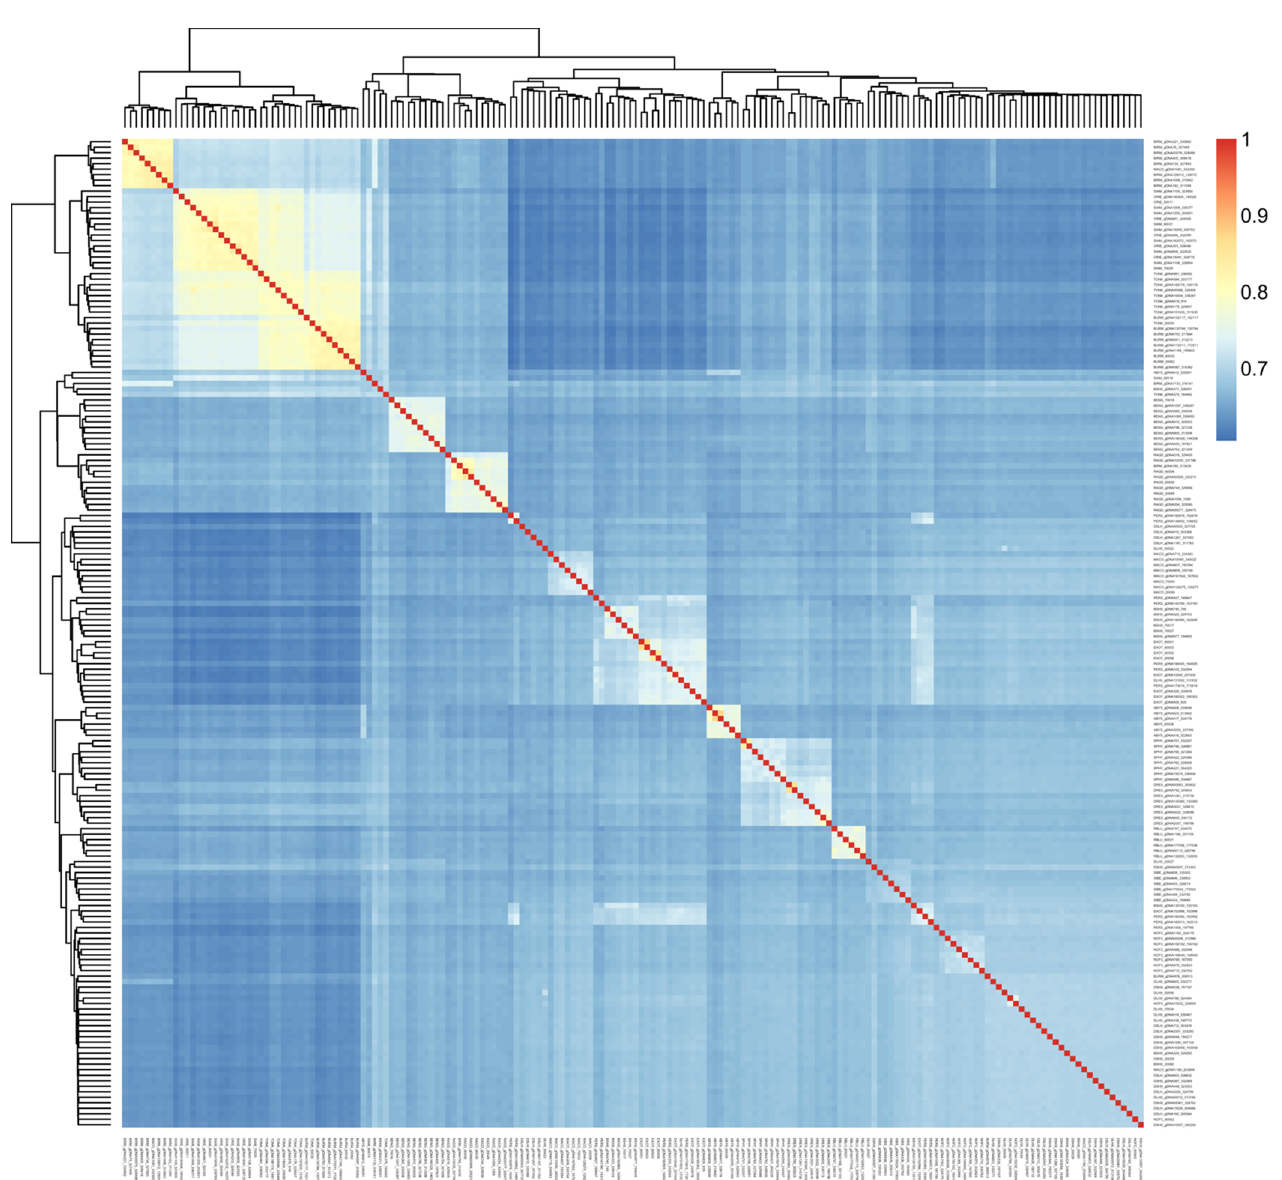
Figure A1. IBS matrix of the balanced data ordered by hierarchical clustering.